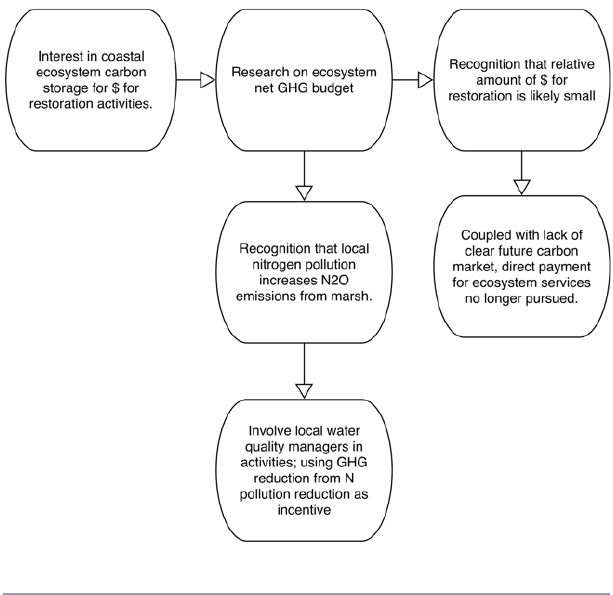
Fig. 3 . Conceptual diagram of re-articulation of greenhouse gas (GHG) ecosystem services in terms of local water quality